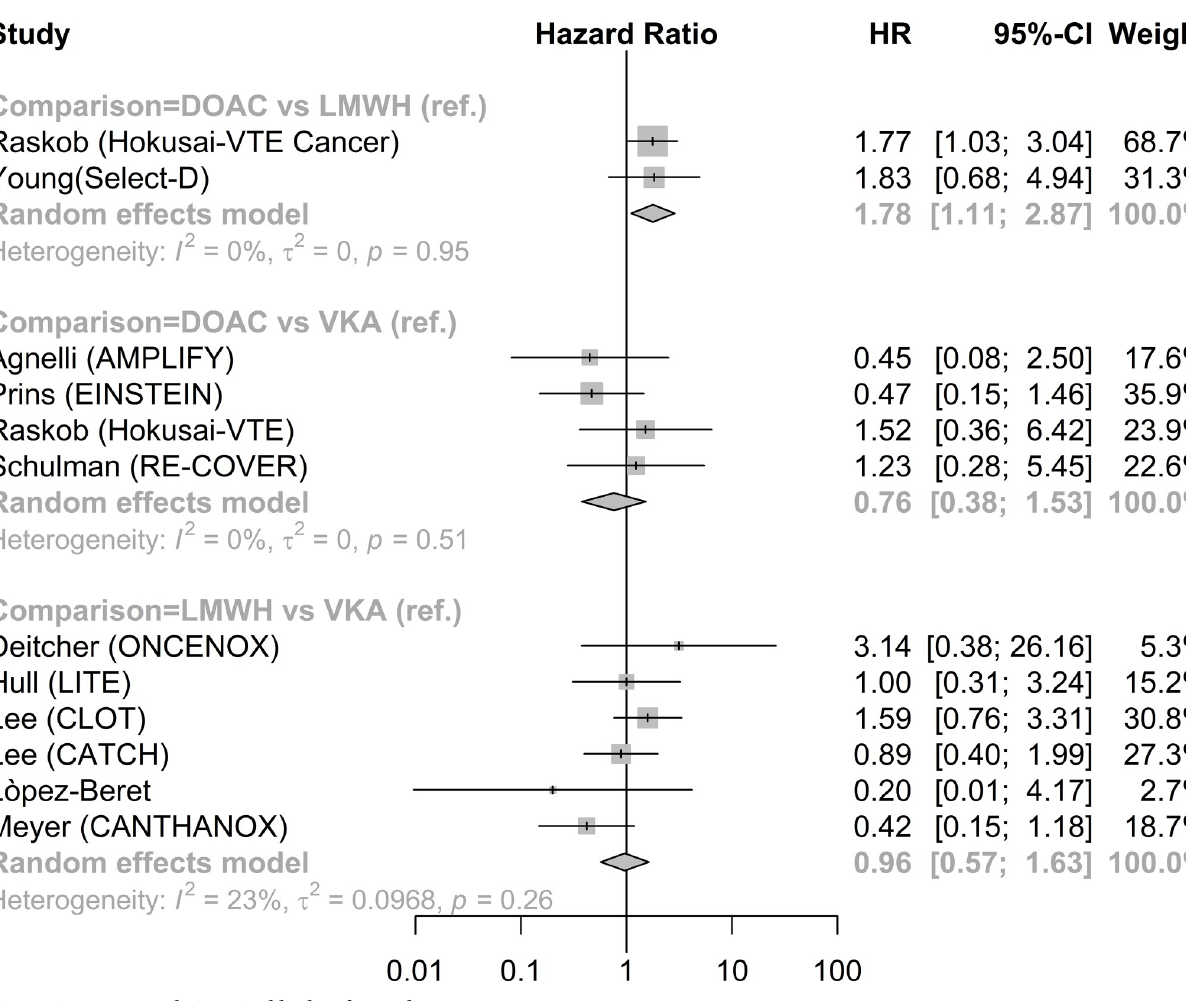
Fig 4. Direct meta-analysis major bleeding forest plot.